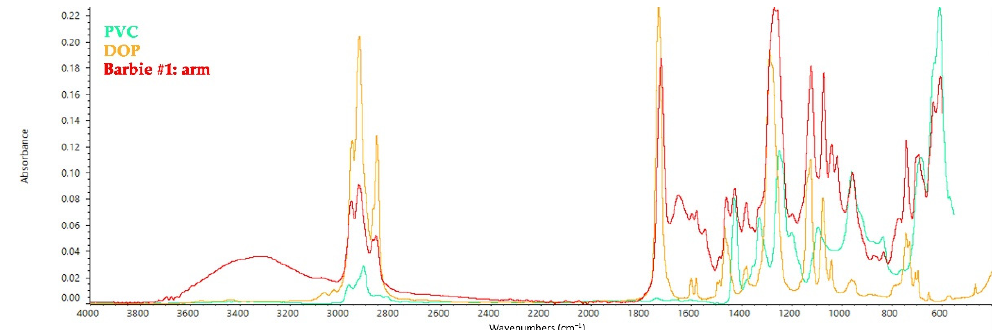
Figure 1. FT-IR ATR spectrum collected on the arm of Barbie #1 and shown as a model spectrum of PVC elements in all the other dolls, with the reference spectra of PVC and n-octyl n-decyl phthalate (plasticizer).